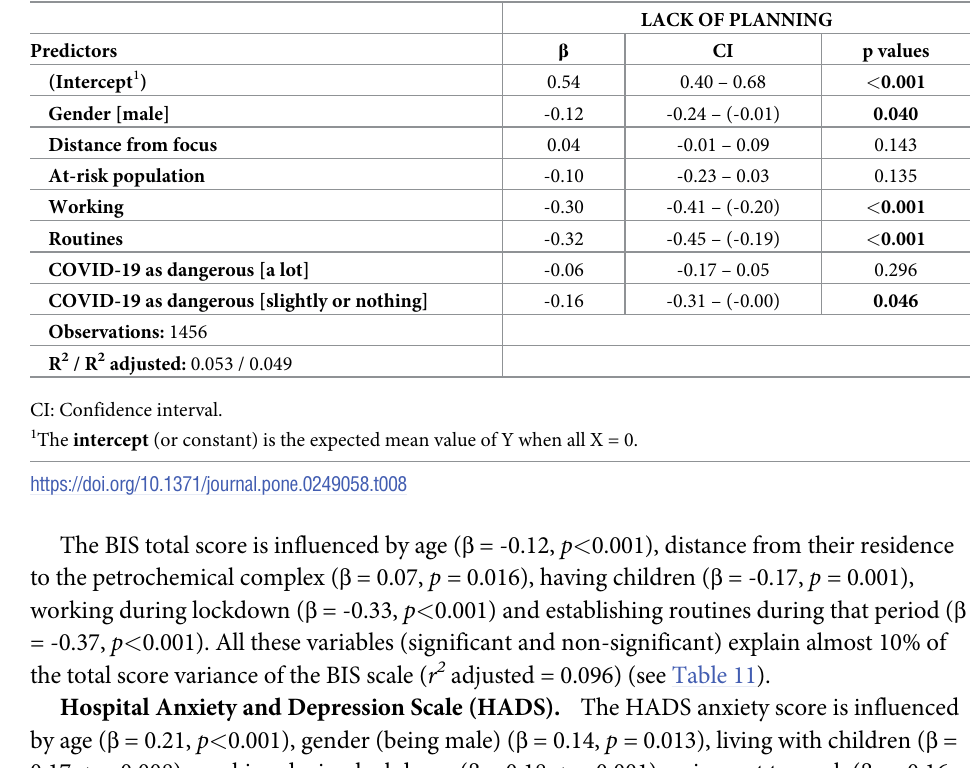
Table 8. Regression analysis relating to lack of planning in the BIS.